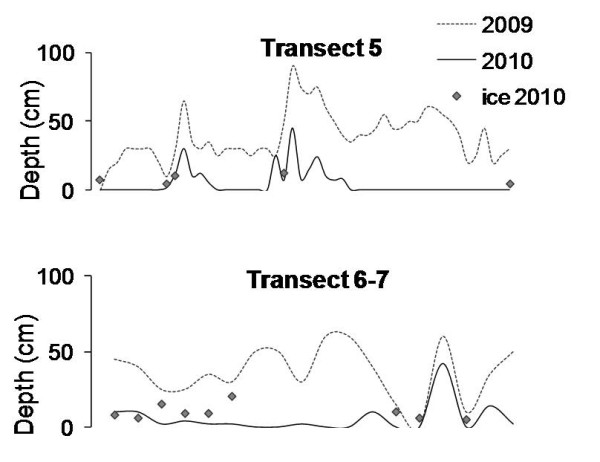
Inter-annual variation in snow depth. Snow depth measured along transects 5 and 6-7 in 2009 and 2010. Dotted line: snow depths in 2009; solid line: snow depths in 2010. Grey dots represent ice thickness measured in 2010.